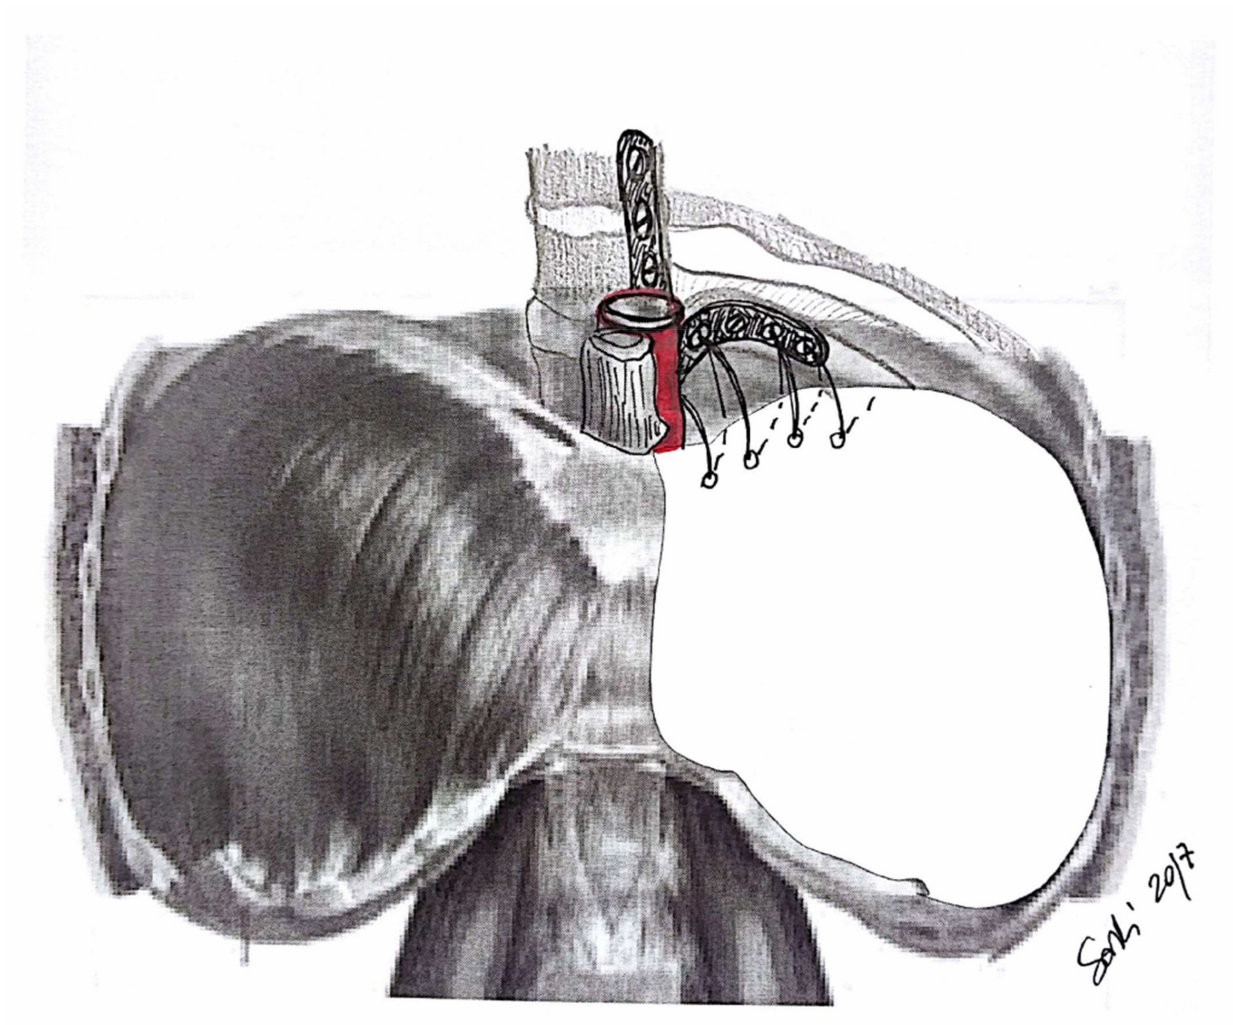
Figure 3. An L-shaped titanium plate used to fix the diaphragmatic patch as described by Schiavon et al. (credits: Solli, P.; Brandolini, J.; Pardolesi, A.; Nardini, M.; Lacava, N.; Parri, S.F.; Kawamukai, K.; Bonfanti, B.; Bertolaccini, L. Diaphragmatic and pericardial reconstruction after surgery for malignant pleural mesothelioma . J. Thorac. Dis. 2018, 10,